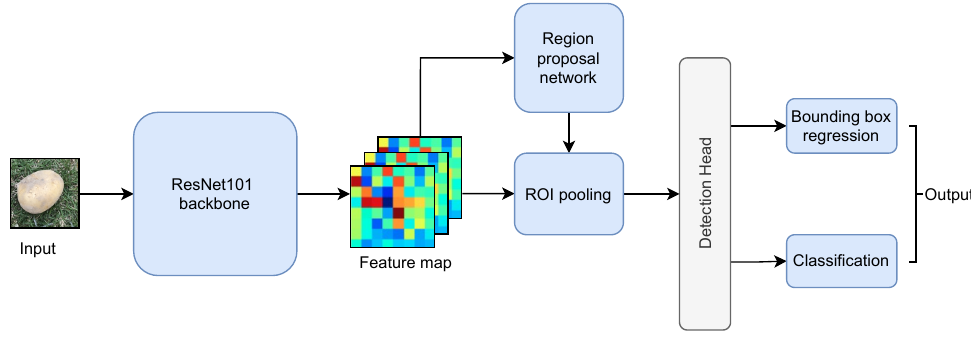
Figure 7. The Faster RCNN RseNet101.